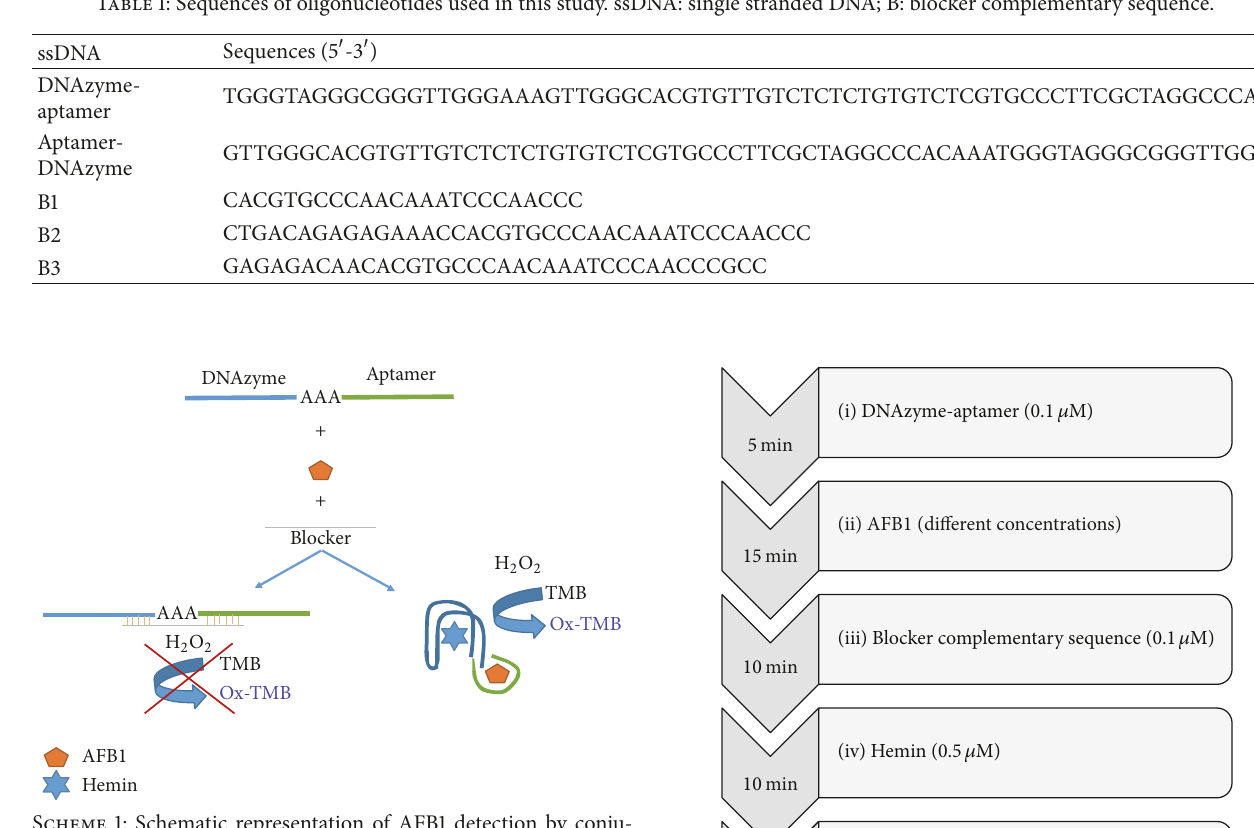
Scheme 1: Schematic representation of AFB1 detection by conju- gated DNAzyme-aptamer.